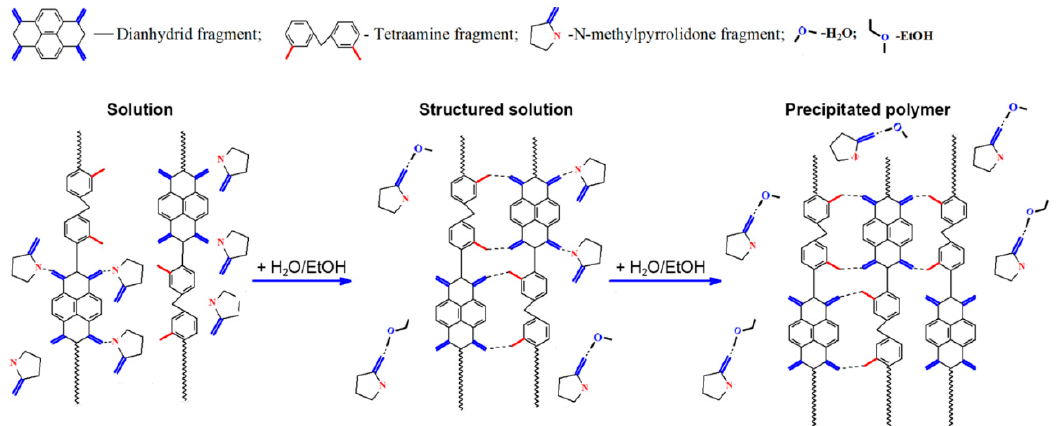
Figure 19. Schematic image of the interaction of PANI-O with a solvent and a non-solvent.